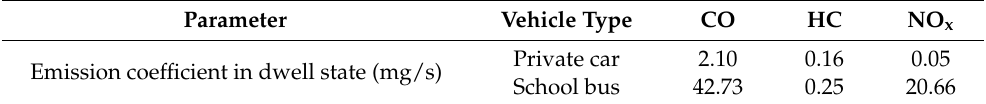
Table 8. Emission coefficient in dwell